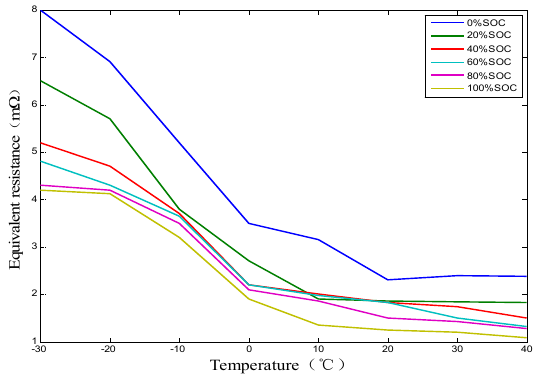
Figure 3. Cell equivalent resistance as a function of SOC and temperature.